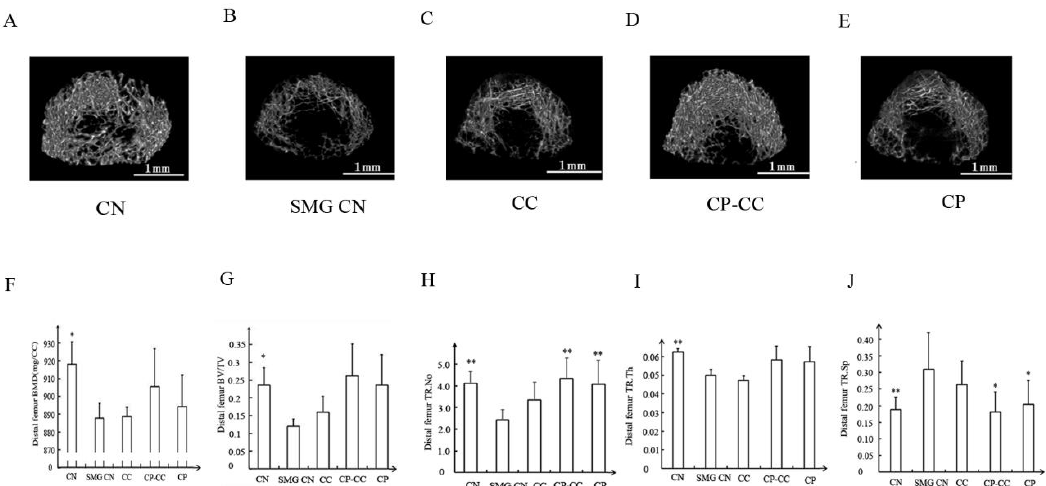
Figure 3. Representative three-dimensional microcomputed images ( A–E ) and ( F–J , BMD, BV / TV, TR.N, TR.Th, TR.Sp) analysis of the microstructural indices of distal femurs in each group ( n = 5) CN, normal gravity control group; SMG CN, tail-suspended simulated microgravity (SMG) control groups; CC, SMG rats treated once-daily with 75 mg / kg calcium citrate (CC); CP–CC, SMG rats treated once-daily with 750 mg / kg bovine collagen peptide (CP) combined with 75 mg / kg CC; CP, SMG rats treated once-daily with 750 mg / kg bovine CP. BV / TV, bone volume / tissue volume; Tb.N (TR.No), trabecular number; Tb.Th (TR.Th), trabecular thickness; Tb.Sp (TR.Sp), trabecular separation. * p < 0.05 vs. SMG group. ** p < 0.01 vs. SMG group. Scale bars, 1 mm.